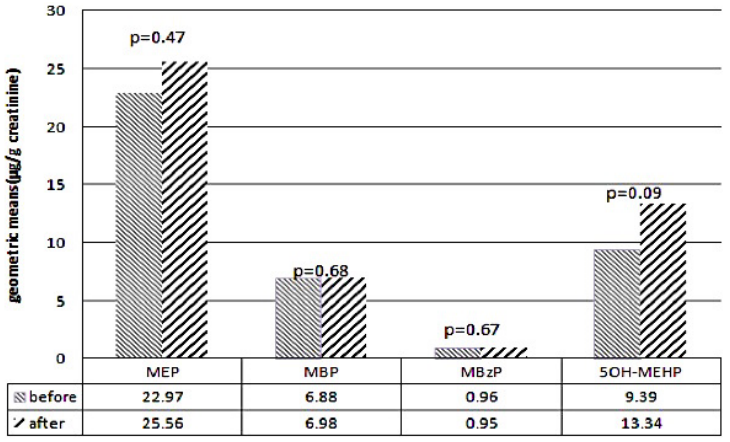
Figure 1. Levels of urinary phthalate metabolites before and after DEHP contaminated food event.